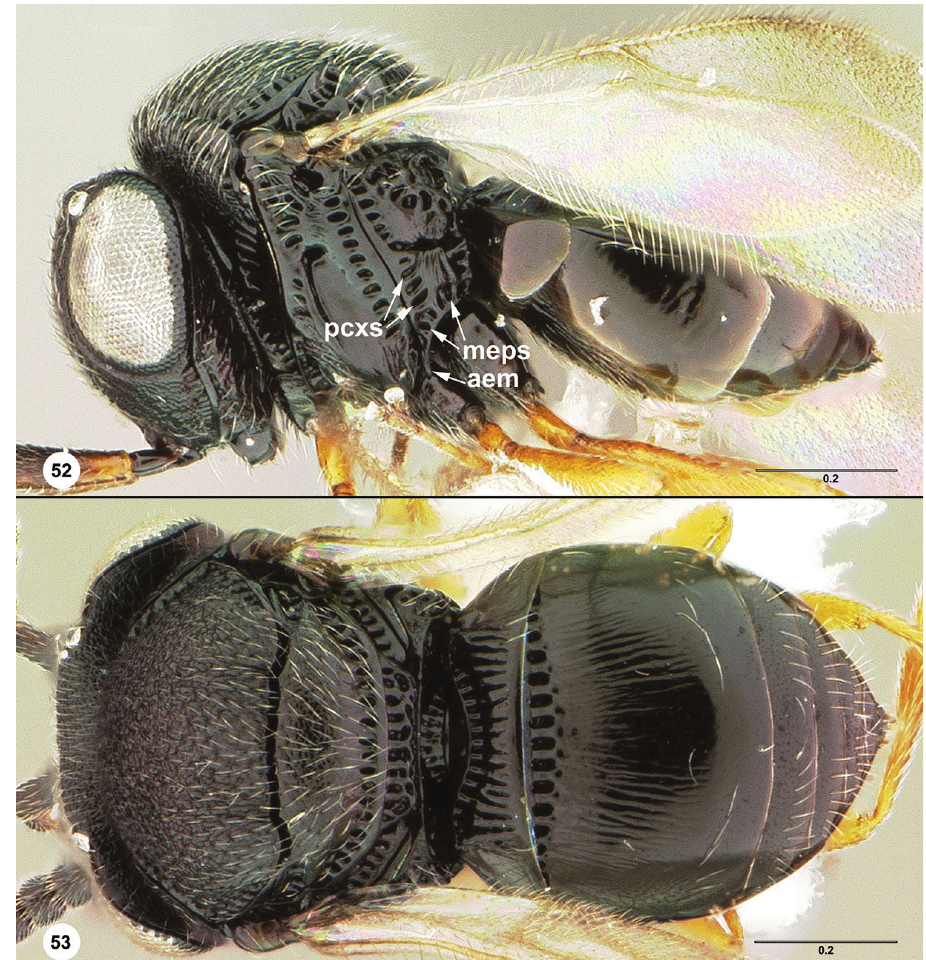
Figures 52–53. T. elasmuchae , female (USNMENT00896150) 52 head, mesosoma, metasoma, lateral view 53 head, mesosoma, metasoma, lateral view. Scale bars in millimeters. posteriorly striate. Orbital furrow: medially delimited by ridge or carina at midpoint of eye, poorly defined or absent near intersection with malar sulcus; uniform in width between midpoint of eye and malar sulcus. Macrosculpture of frons between antennal scrobe and anterior ocellus: absent; strigose, roughly concentric around median ocel- lus; transversely strigose. Preocellar pit: present. Setation of lateral frons: moderately dense. Punctation of lateral frons: absent. Sculpture directly ventral to preocellar pit: dorsoventrally fluted. Macrosculpture of lateral frons: absent; rugose; horizontally stri- ate ventrally, striae of antennal scrobe extending to lateral frons. OOL: lateral ocellus and eye without continuous scleritic separation; separated by less than one ocellar di- ameter. Hyperoccipital carina: present only posterior to lateral ocellus; absent.